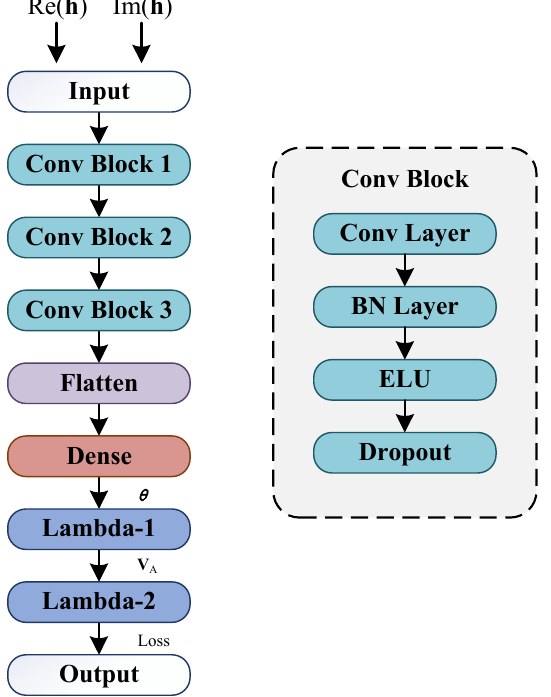
Figure 2. The proposed neural network architecture for hybrid beamforming design. Table 1. Parameters of the Proposed DL-based HBF